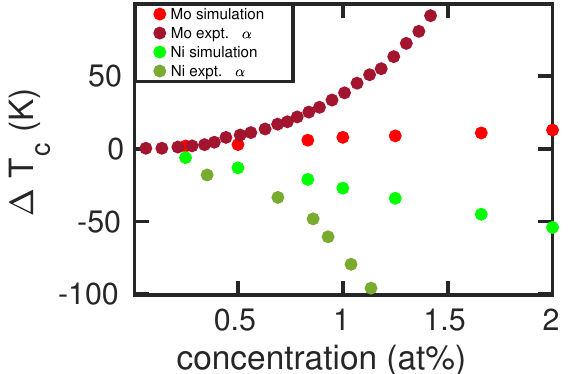
Figure 5. Change in the α - γ transition temperature, ∆ T c , induced by Mo and Ni atoms in Fe as a function of concentration of the alloying elements. Simulation results are compared to experimental data [6] of the boundary of the α